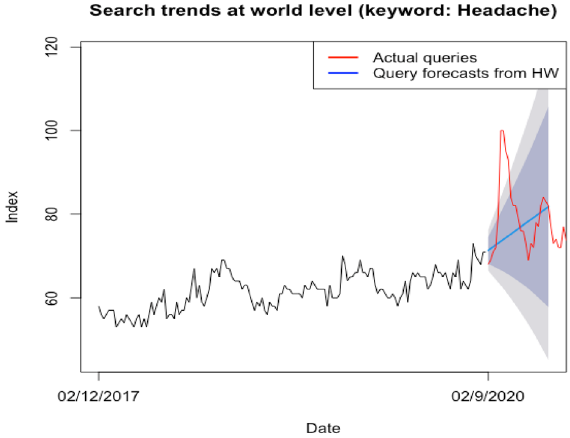
Figure 5. Historical trends and forecasted values for web queries for the term